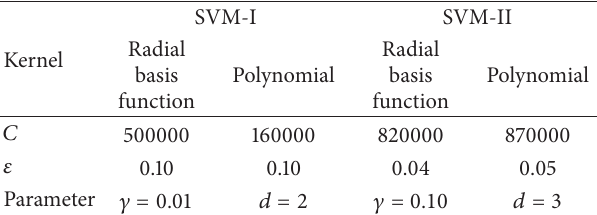
Table 1: Parameters of SVM-I and